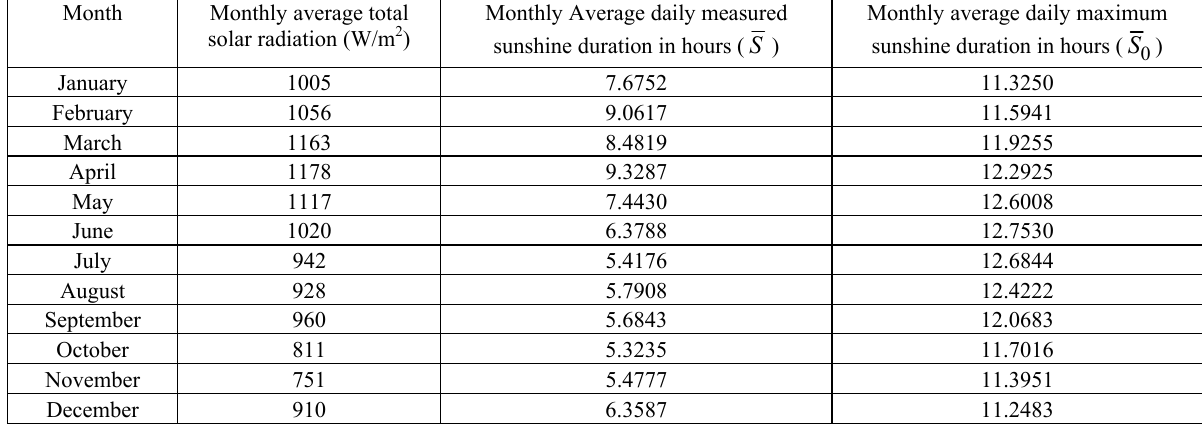
Table 3. Measured solar radiation data (from January 2014 to December 2014) [33] Month